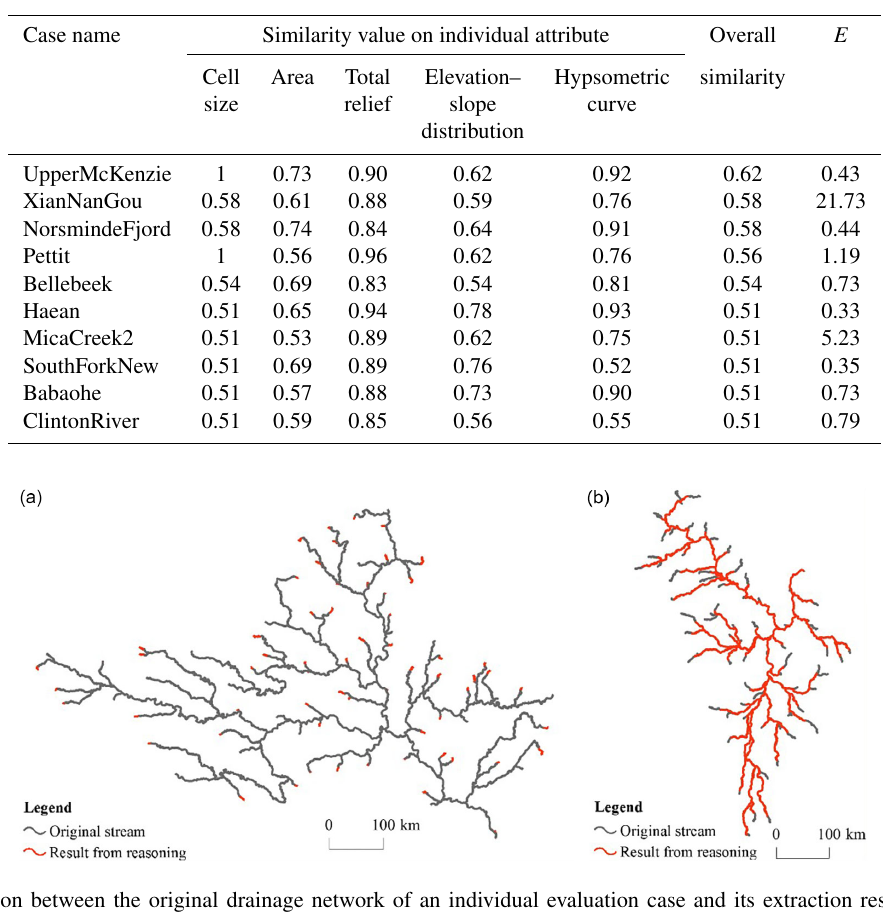
Figure 4. Comparison between the original drainage network of an individual evaluation case and its extraction result using case-based reasoning: (a) Godavari case with an underestimated CA threshold and (b) Burdekin case with an overestimated CA